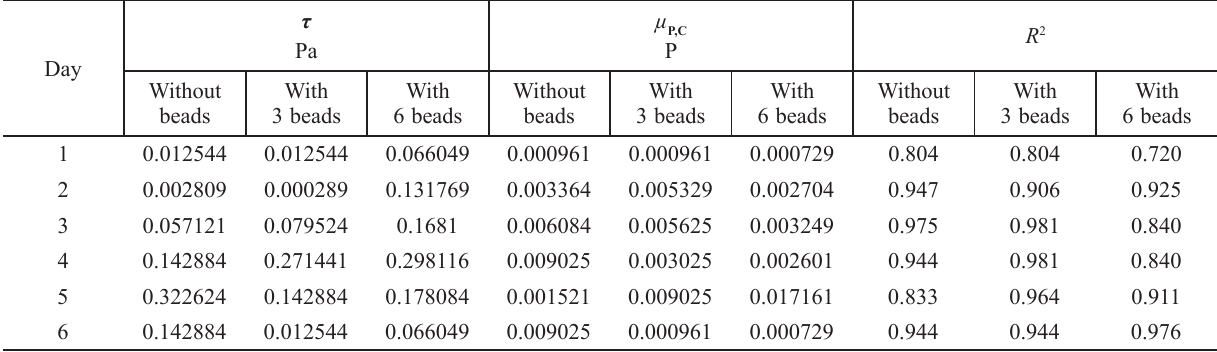
Table 2 – Casson model parameters for cell grown without beads, with 3 beads, and with 6 beads